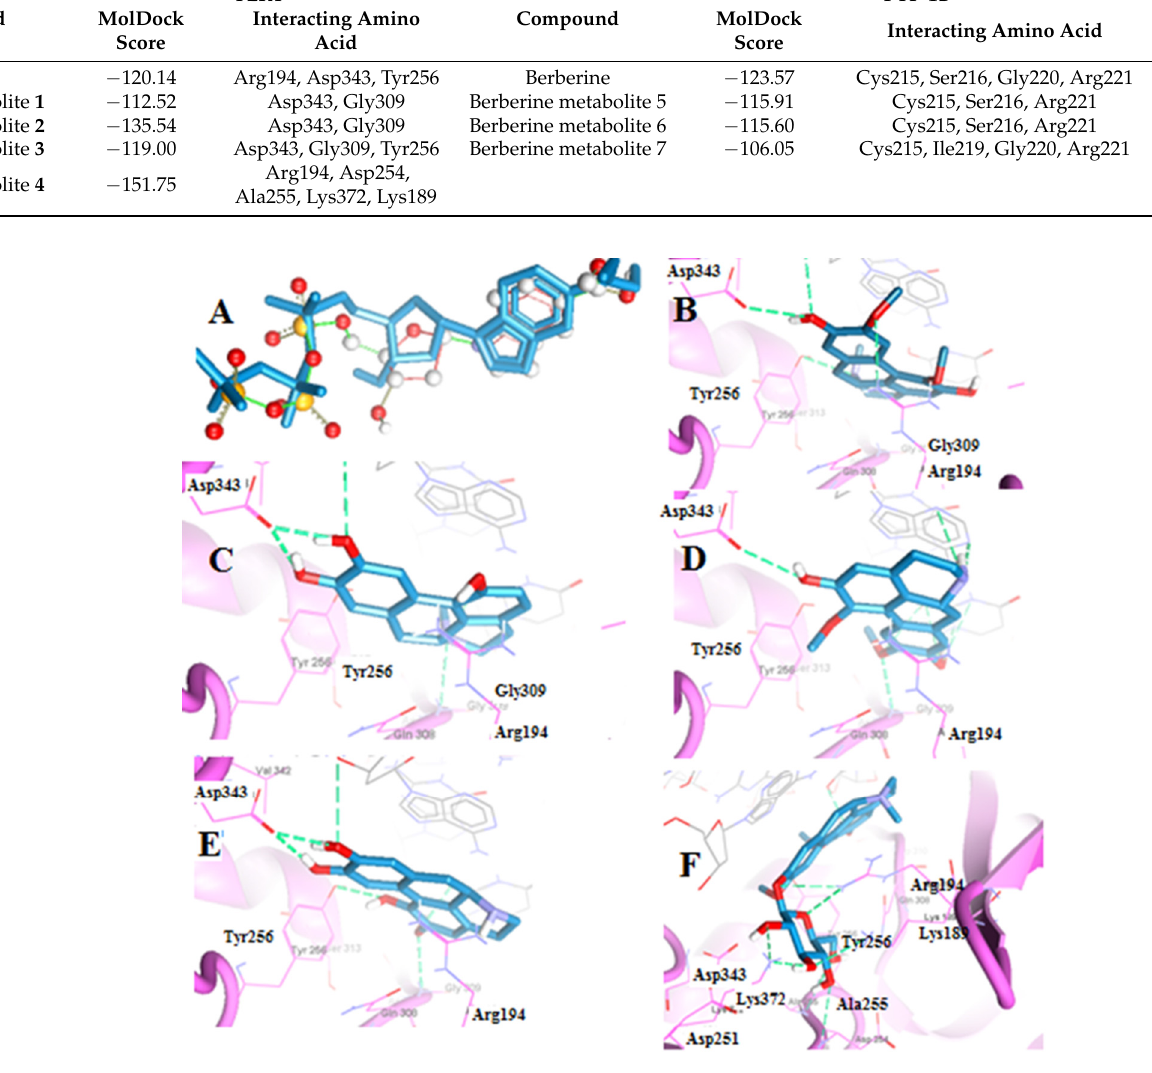
Figure 3. ( A ) Superimposed co-crystalized and redocked poses of 5-MeCITP in TERT. ( B – F ) Amino acid residues involved in ligand interaction shown as dashed lines with boldine, boldine metabolites 1, 2, 3 and 4, respectively.